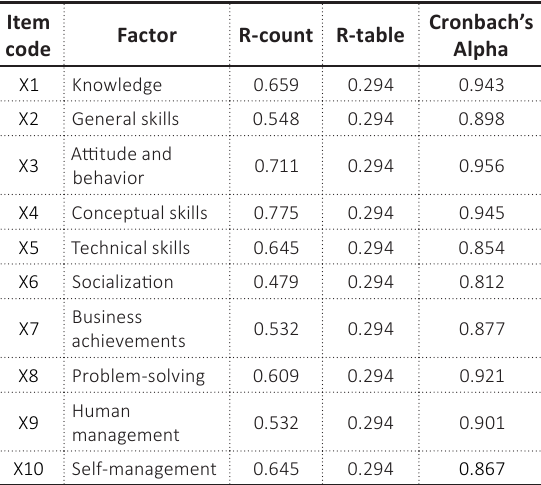
Table 1. Validity and reliability test results